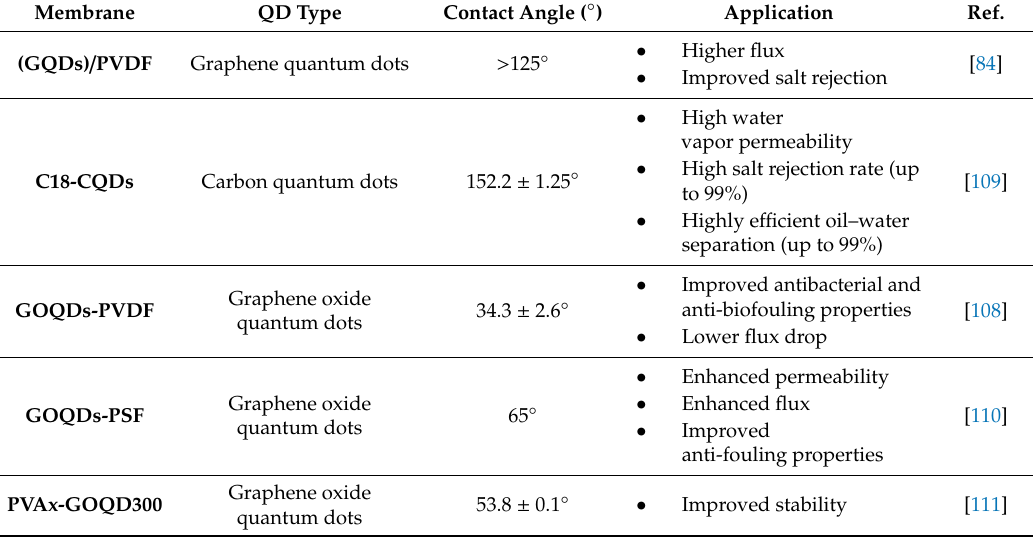
Table 3. An overview of feasible methodologies to cast quantum dots (QDs)-doped hydrophobic polymeric membranes and the overall outcome.